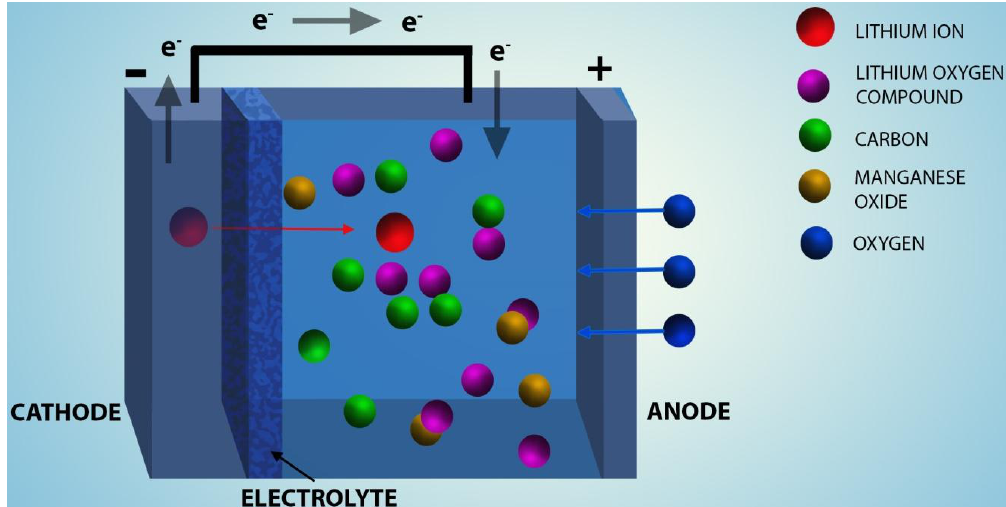
Figure 3. Lithium-air battery